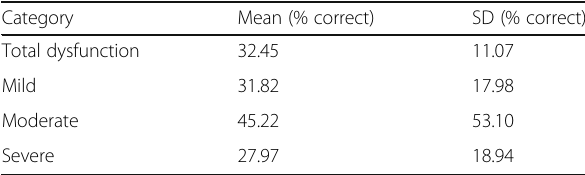
Table 6 Experiment 2: Mean percentage accuracy for